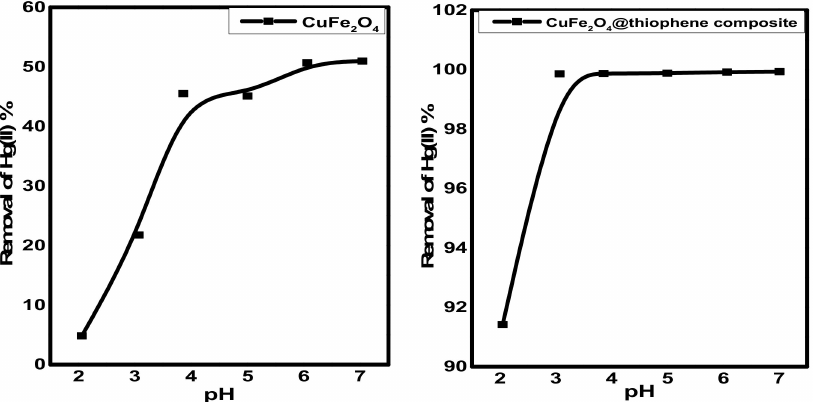
Figure 9. E ff ect of pH on Hg(II) removal from aqueous solution [Conditions: initial conc. of Hg(II) solution = 10 mg / L, contact time = 3 h and 30 min. for CuFe 2 O 4 and CuFe 2 O 4 @Polythiophene composite; respectively, adsorbent dose = 0.03 g, volume of Hg(II) solution = 50